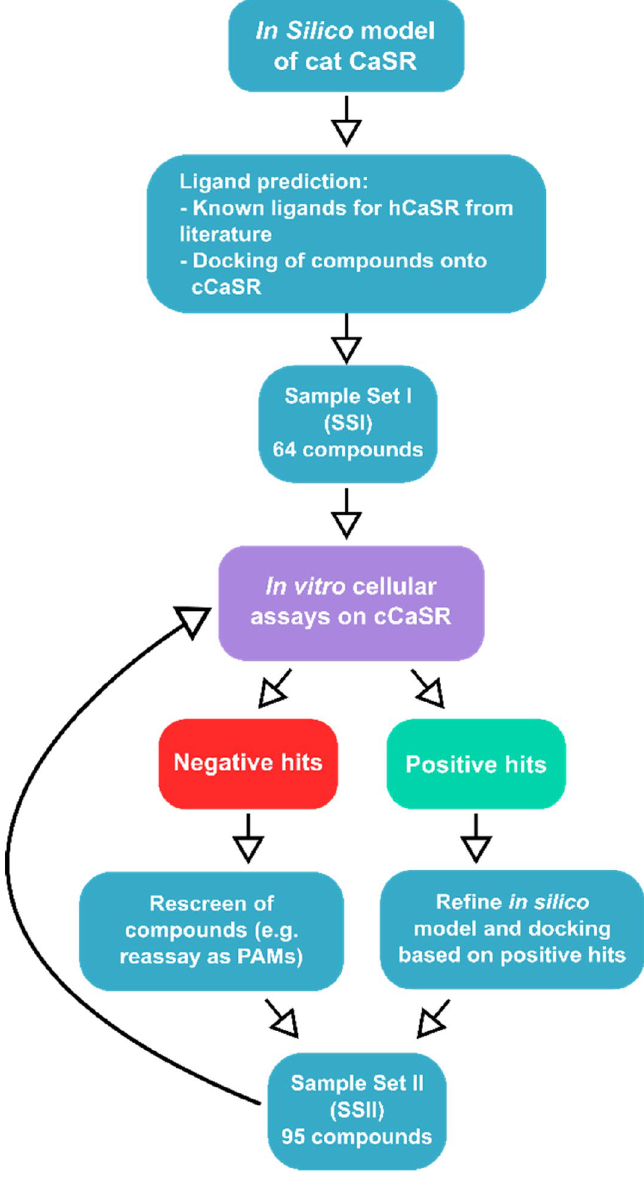
Figure 4. Schematic representation of the hypothesis driven, iterative approach used to predict ligand binding into cCaSR. In the process, we used information from literature on hCaSR, as well as our homology model used for docking. Between sample set I and sample set II, some compounds were repeated, and a final number of 159 unique compounds were screened on